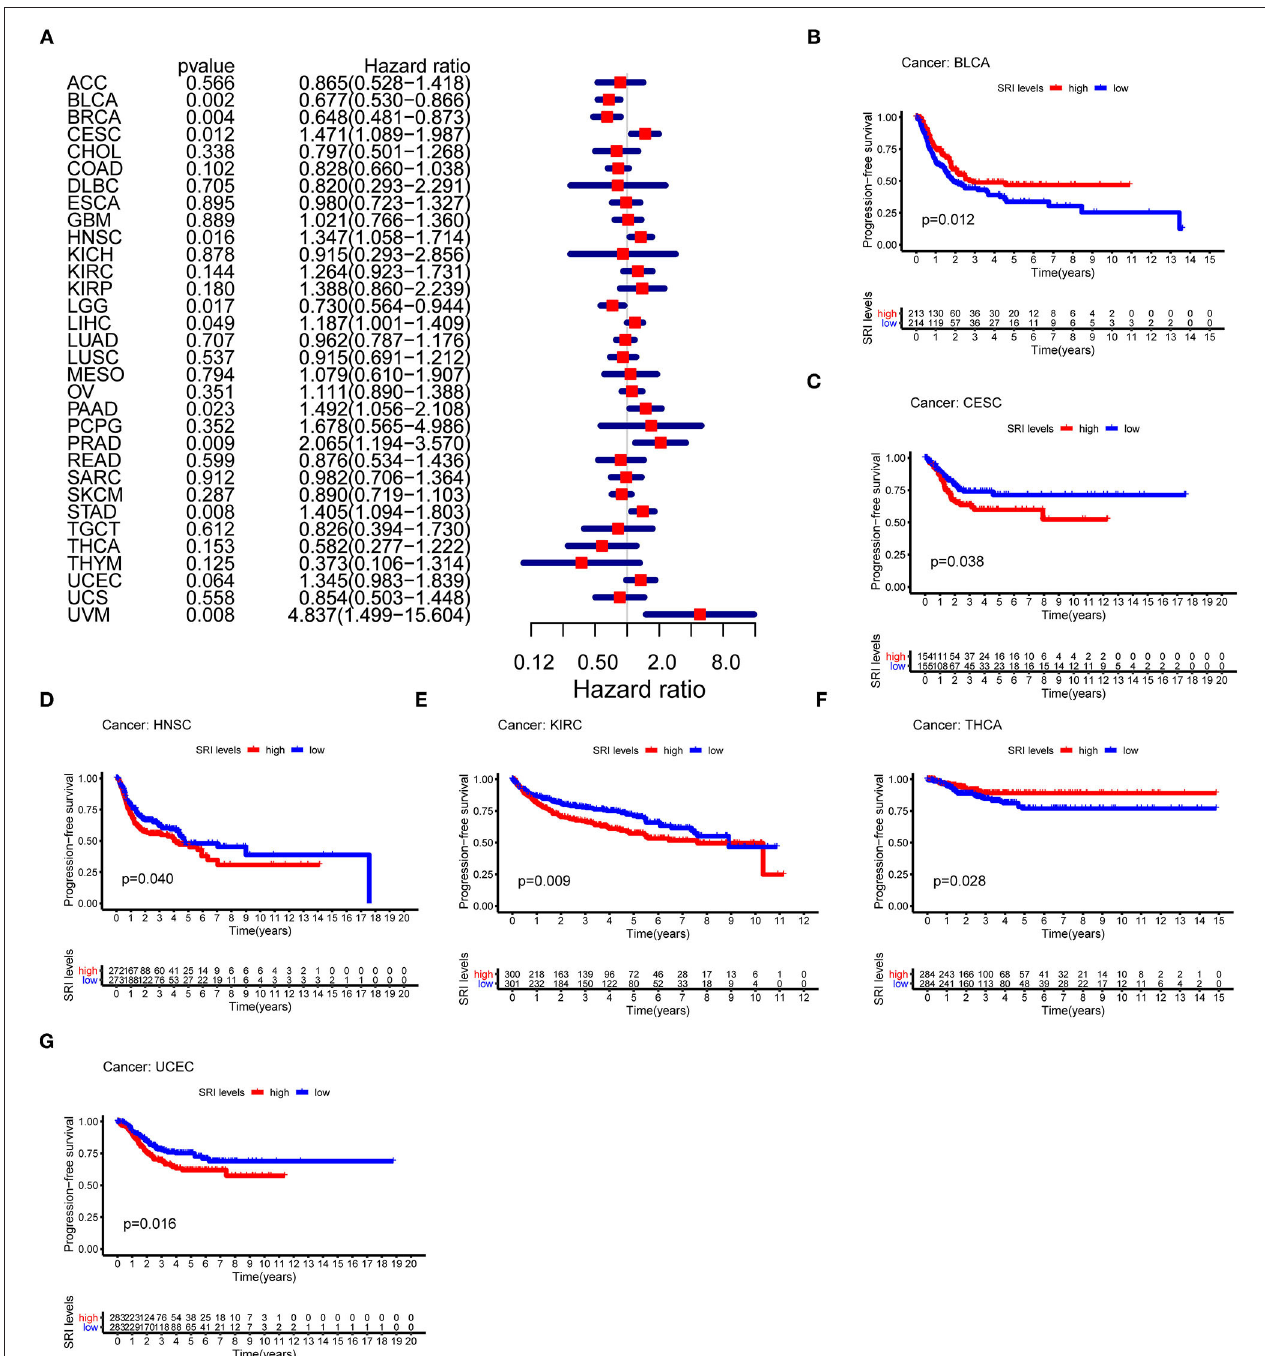
FIGURE 3 | The Cox proportional hazards model and Kaplan–Meier analysis of progression-free survival (PFS) time by the SRI expression. (A) A forest plot of the associations of SRI expression and PFS in 33 types of tumor (B–G) Kaplan–Meier analysis of the correlations between the SRI expression and PFS. A red line represents the high SRI expression, and the blue lines represent the low SRI expression.